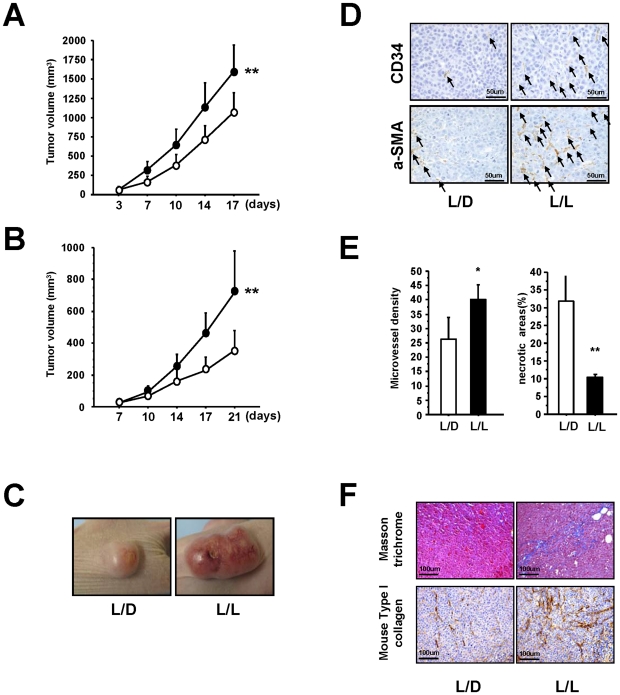
Effect of photoperiod manipulation on the growth of human HeLa cell or PC3 cell tumors.(A) Hela cell tumors. Volume of the subcutaneous xenografts in nude mice housed in either L/L (closed circle; n = 16) or L/D (open circle; n = 16) conditions. After 17 days of growth, L/L tumors were significantly larger than L/D tumors (F from repeated measure ANOVA = 12.276, **P<0.01). (B) PC3 cell tumors. Volume of the subcutaneous xenografts in nude mice housed in either L/L (n = 8) or L/D (n = 8) conditions. A significant reduction in volume is seen in the L/D tumors compared with the L/L tumors (F from repeated measure ANOVA  = 18.360, **P<0.01). (C) Representative photograph of L/L and L/D tumors showing the obvious difference in size. (D) Immunohistochemical analysis of CD34 positive (CD34+) cells and aSMA positive (aSMA+) cells in the L/L and L/D tumors. Increased numbers of CD34+ and aSMA+ (black arrows) are clearly visible in the L/L tumors. (E) The number of microvessels was quantified using the number of CD34+ cells. An increase in microvessel density (vessels in 10 viewing fields; n = 3 per group, *P<0.05), is accompanied by a decrease in necrosis (n = 3 per group **P<0.01). (F) Representative photographs showing masson trichrome staining of the expanded extracellular matrix and immunohistochemical analysis of mouse Type I collagen in the L/D and L/L tumors.